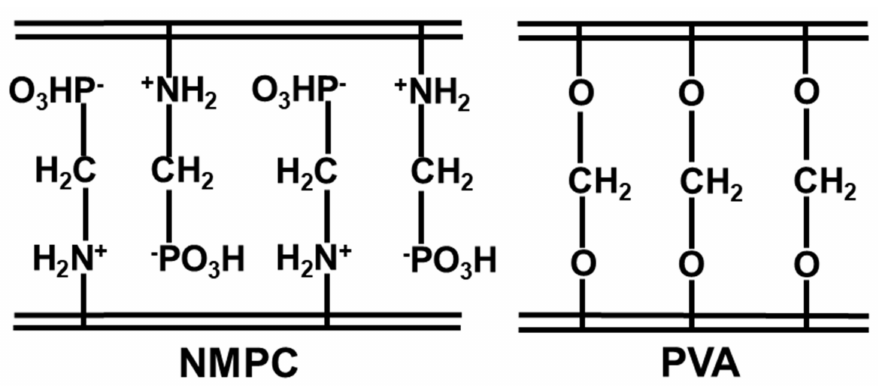
Figure 6. Schematic of zwitterionic structure in NMPC/PVA composite membrane. 3.3. N-Methylene Phosphonic Chitosan/Poly (Vinyl Alcohol) Composite Membranes Modified with SiO 2 Filler (NMPC/PVA-SiO 2